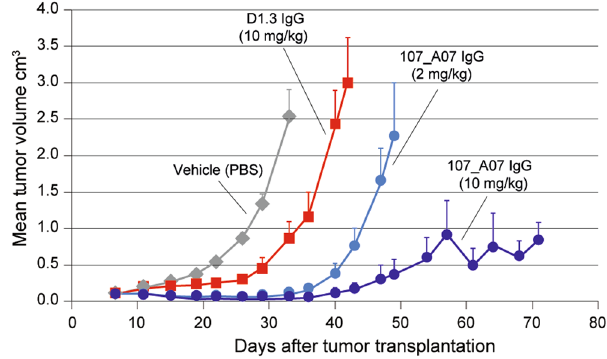
Figure 2. Effect of 107_A07 IgG on the growth of subcutaneous U87MG xenografts. Following xenograft implantation on day 0, mice (n = 8) were given vehicle alone (PBS), control D1.3 IgG (10 mg/kg) or 107_A07 IgG (2 or 10 mg/kg) intraperitoneally at day 7 and then every 3–5 days for 26 days. Tumor volumes were measured by caliper twice